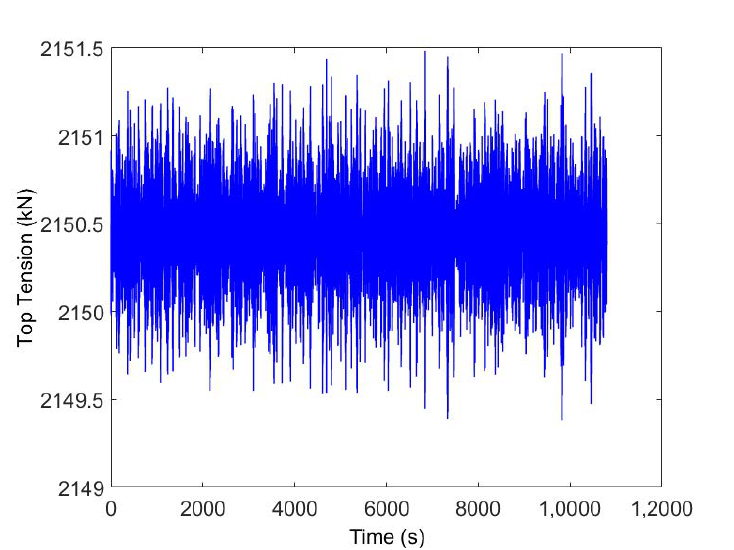
Figure 22. Top tension in time series (3 h) of multicomponent